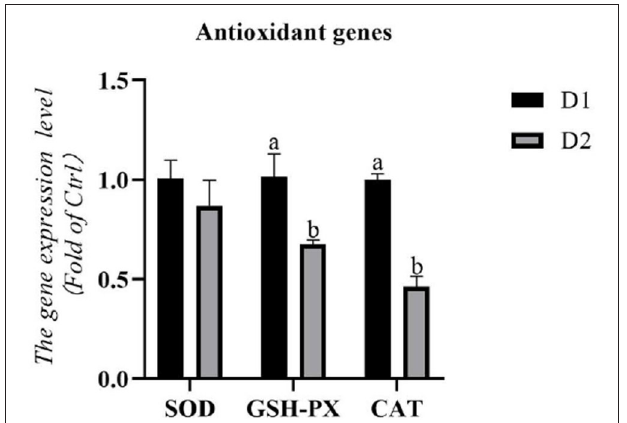
FIGURE 3 | Hepatopancreas RNA expression levels of digestive and metabolic enzyme genes of L. vannamei fed diets supplemented with/without Klebsormidium sp. for 56 days. a , b The small letters indicated significant differences at p <